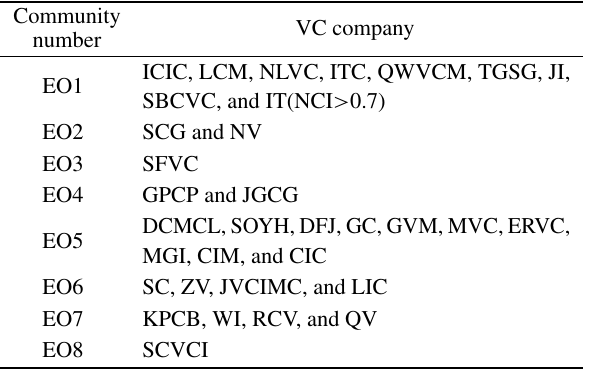
Table 9 VC companies with NCI greater than 0.6 in EO detection results.